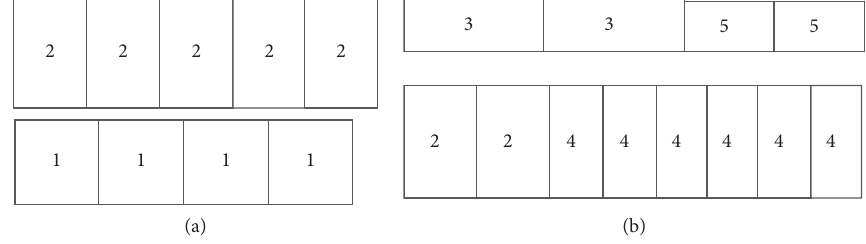
Figure 2: Two types of strips. (a) Homogenous strips. (b) General strips.